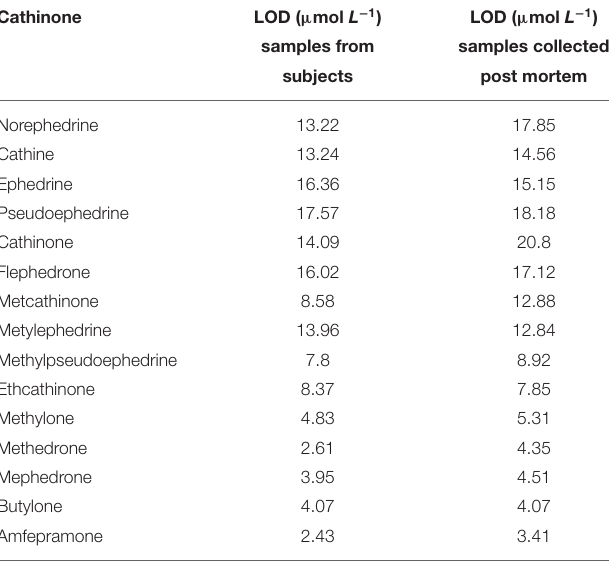
as the monomer. MIF was synthesized by electro-polymerization. TABLE 2 | Limits of detection determined in live and post-mortem whole blood samples ( Sørensen,